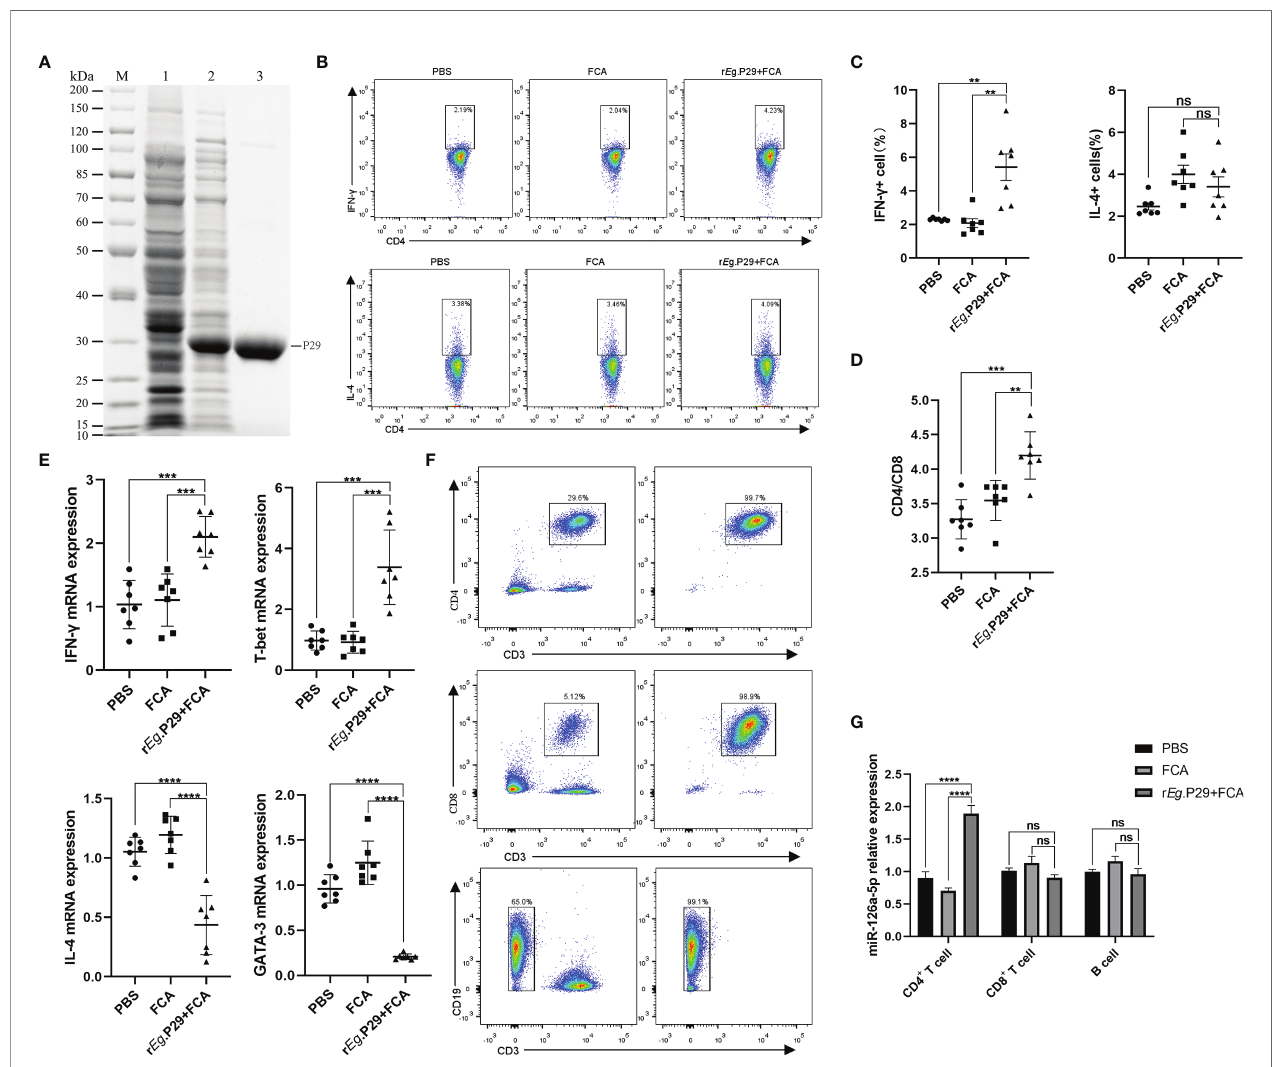
FIGURE 1 | Upregulation of miR-126a-5p expression in splenic CD4+ T cells 1 week after rEg.P29 immunization in mice. (A) rEg.P29 protein in SDS-PAGE: M, protein markers; line 1, Escherichia coli lysates; line 2, induction of E. coli lysates with IPTG; line 3, puri fi ed rEg.P29. (B) Flow assay of IFN-g and IL-4 expression levels in splenic CD4+ T cells 1 week after rEg.P29 immunization. (C) Statistical graph of fl ow analysis of IFN-g and IL-4. (D) Ratio of splenic CD4+T cells to CD8+ T cells 1 week after rEg.P29 immunization. (E) Expression levels of IFN-g, T-bet, IL-4, and GATA-3 in splenic CD4+ T cells after 1 week of rEg.P29 immunization by qRT-PCR. (F) Flow sorting of CD4+ T cells, CD8+ T cells, and B cells from spleen lymphocytes. (G) Expression of miR-126a-5p in CD4+ T cells, CD8+ T cells, and B cells was detected by qRT-PCR. **P<0.01, ***P < 0.001, ****P < 0.0001; ns, not signi fi